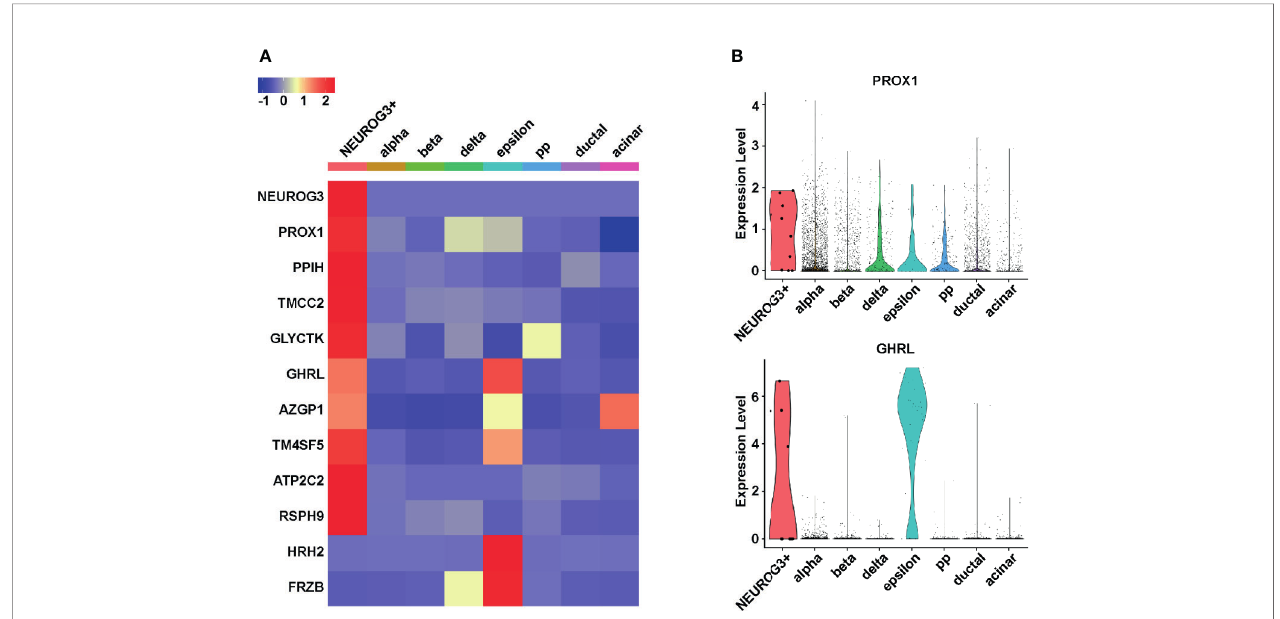
FIGURE 2 | NEUROG3+ cells have unique gene expression signatures. (A) Heatmap demonstrates the average expression of the 10 most upregulated and two most downregulated transcripts in NEUROG3+ cells compared to other pancreatic epithelial cell types. The color scale is based on the normalized Z-score of each transcript. (B) Violin plots display the expression levels of PROX1 and GHRL in different cell populations. Each dot represents one